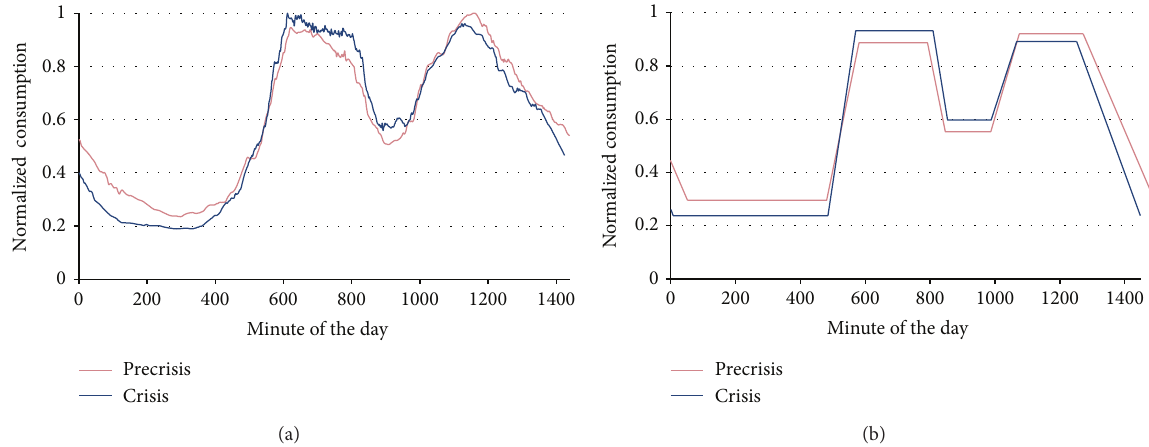
Figure 12: (a) Normalised representative curves of the base date in the two time periods (precrisis and crisis). (b) Linearized representative curves.